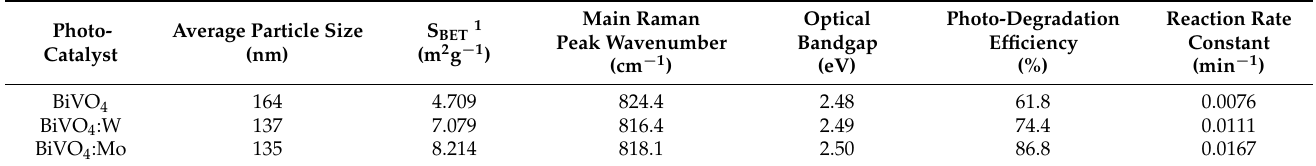
Table 1. Microstructural features, optical characteristics, and photocatalytic activities of hydrother- mally synthesized undoped and impurity-doped BiVO 4